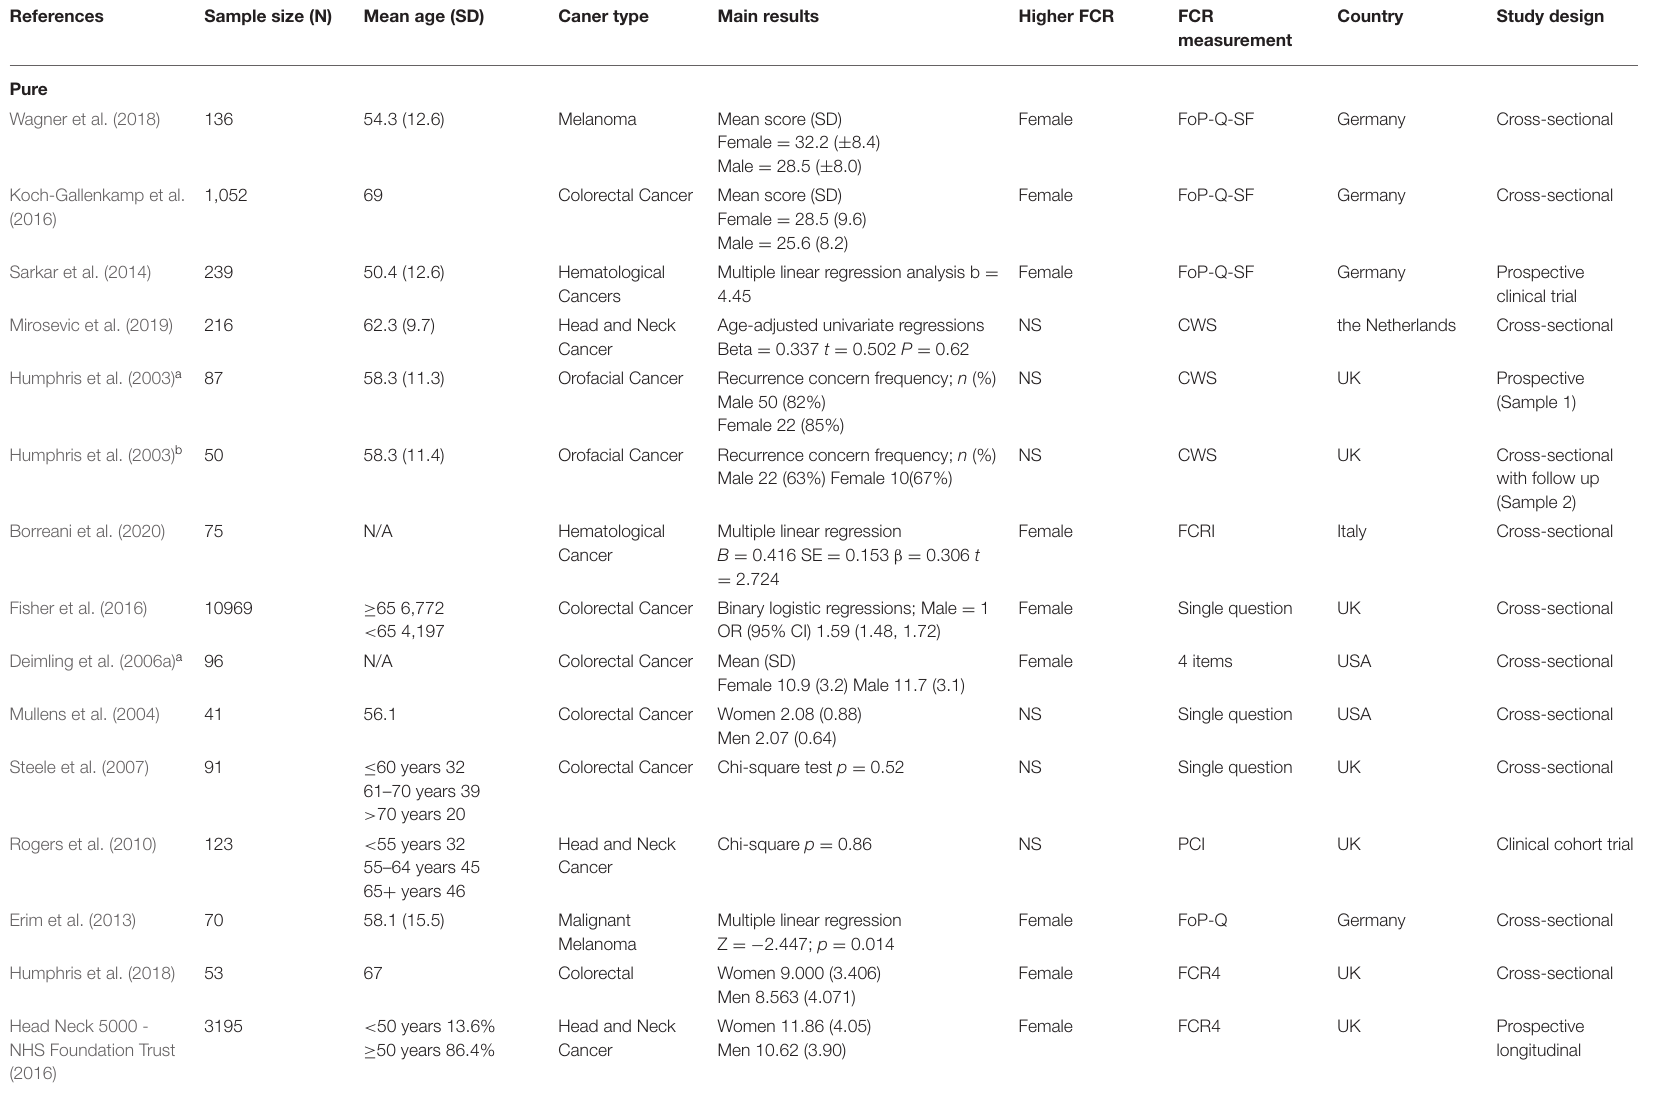
TABLE 1A | Summary characteristics of the included studies in pure